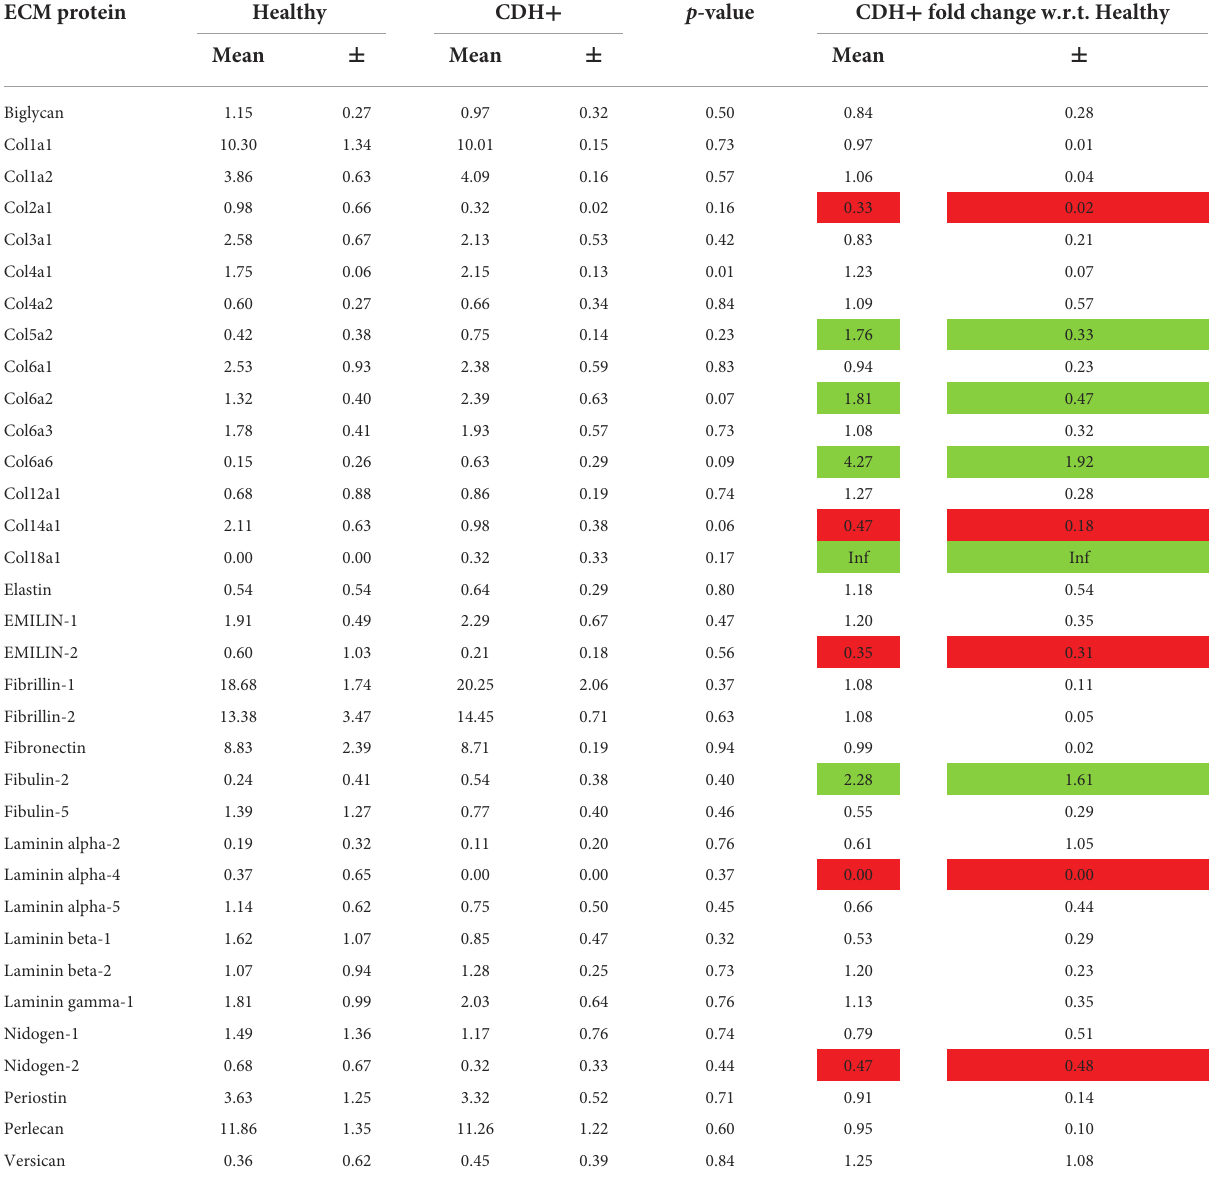
TABLE 1 Relative ECM